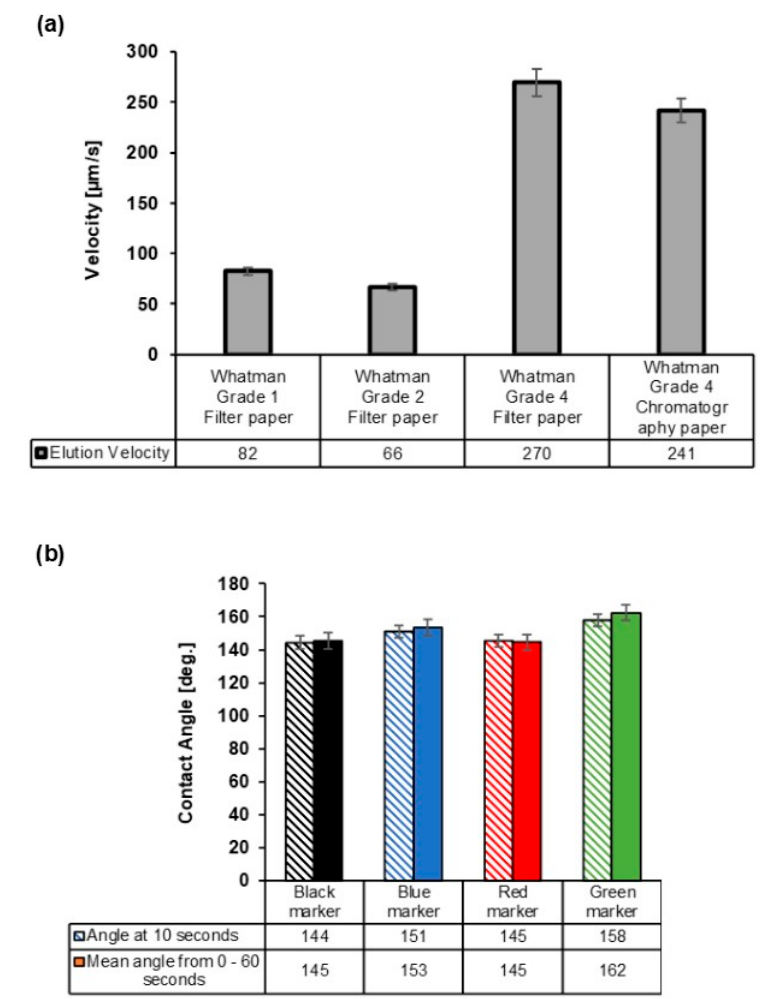
Figure 3. Optimization of the paper-based analytical device’s fabrication with respect to the paper type and marker color. ( a ) The elution velocity of distilled water in different grades of paper. ( b ) The contact angle measurement over time for the black marker, blue marker, red marker, and green marker on Whatman ® Grade 4 filter paper on exposure to drops of HPLC grade water (slanted shade is measurement at 10 s and full color shade is mean measurement over 60 s). Each bar represents the mean of the three individual experiments ± standard deviation.